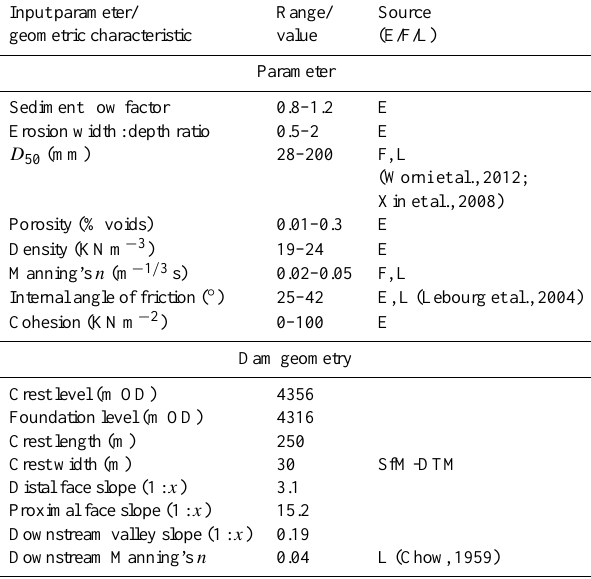
Table 1. Parameter ranges and geometric characteristics of the Dig Tsho moraine dam used for input to the HR BREACH numerical dam-breach model. Input parameter ranges were established from a combination of initial experimentation and parameter sensitivity analysis (E), in situ field observation (F) and data from similar sites stated in the literature (L). All dam geometry data were extracted from the SfM-DTMs of the moraine and floodplain (SfM-DTM), with the exception of downstream Manning’s n , which reflects a sedimentological valley-floor characterisation of gravels, cobbles, and rare large boulders (after Chow,